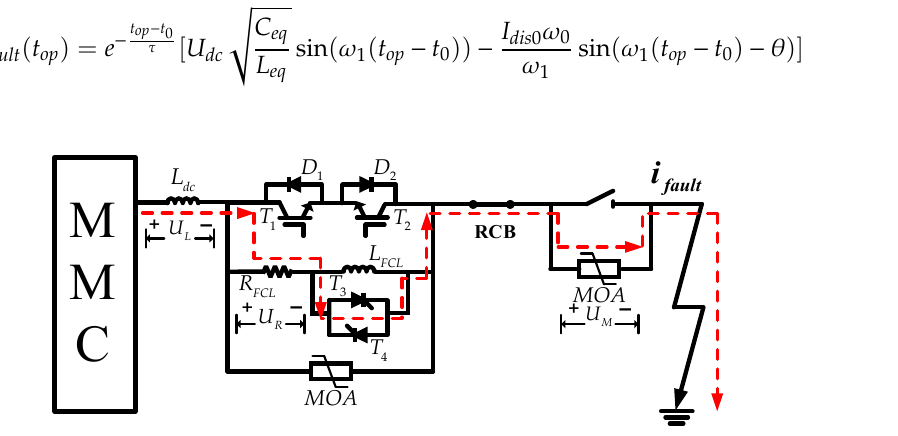
Figure 21. Fault current path during fault interruption.